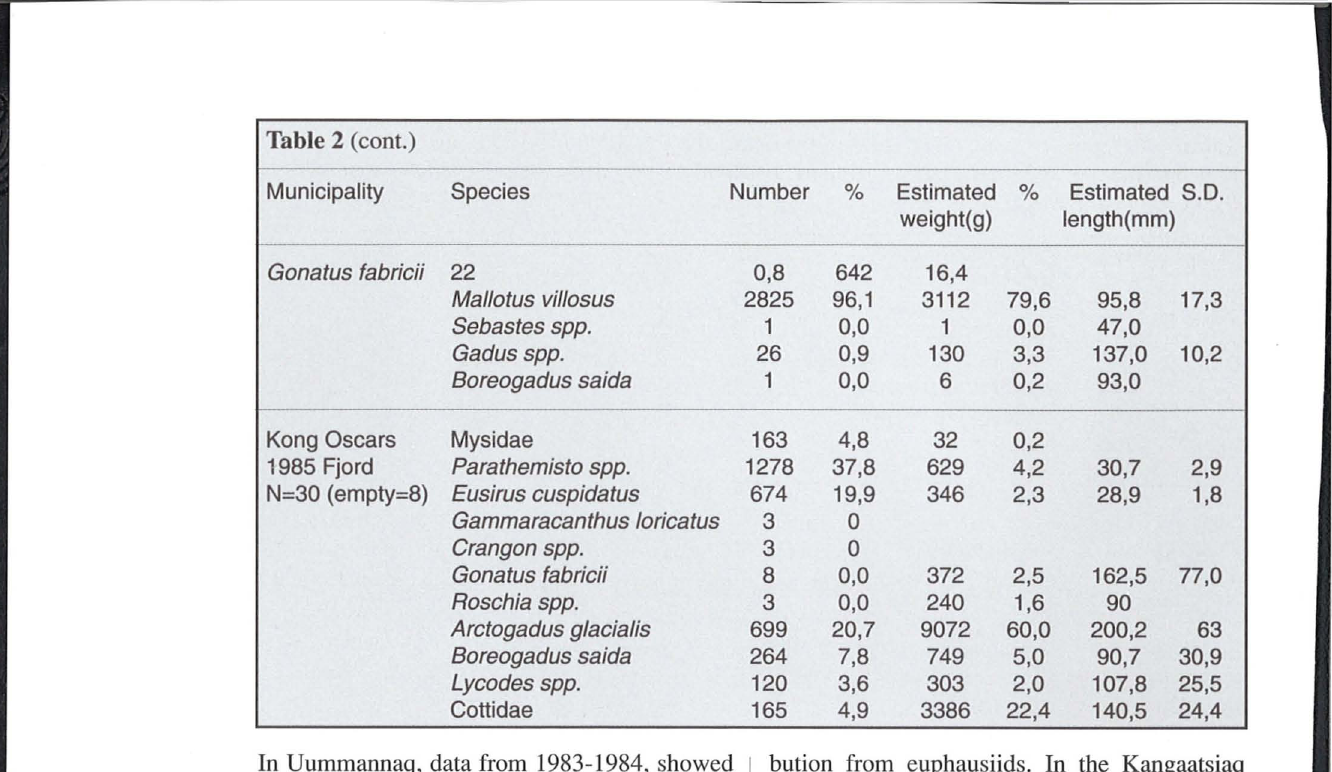
Polar cod (Boreogadus saida) below drift ice in the